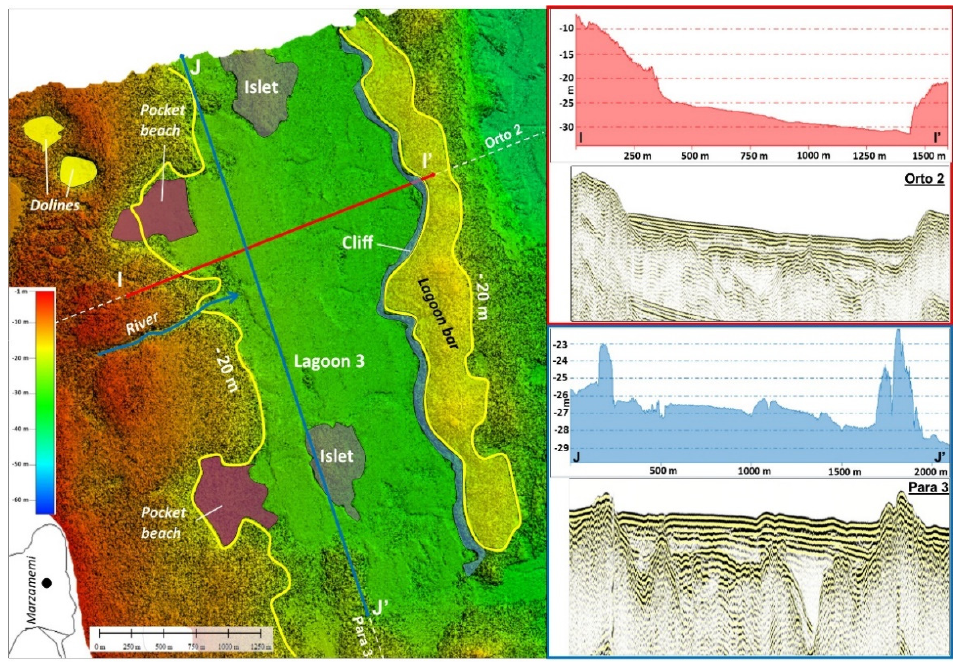
Figure 11. Location of Lagoon 3 (L3) within the Multibeam dataset (profiles I–I ′ and J–J ′ ) and seismic profiles oriented orthogonally (Orto 2) and longitudinally (Para 3) relative to the current Marza- memi coastline. Marzamemi